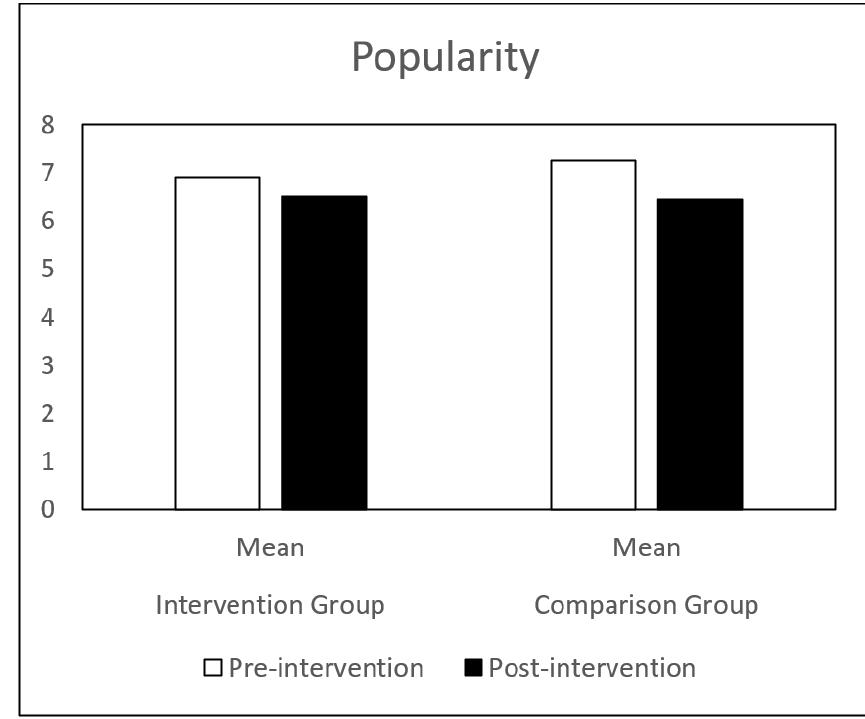
Figure 5. Popularity mean in IG and CG at pre- and post-intervention.